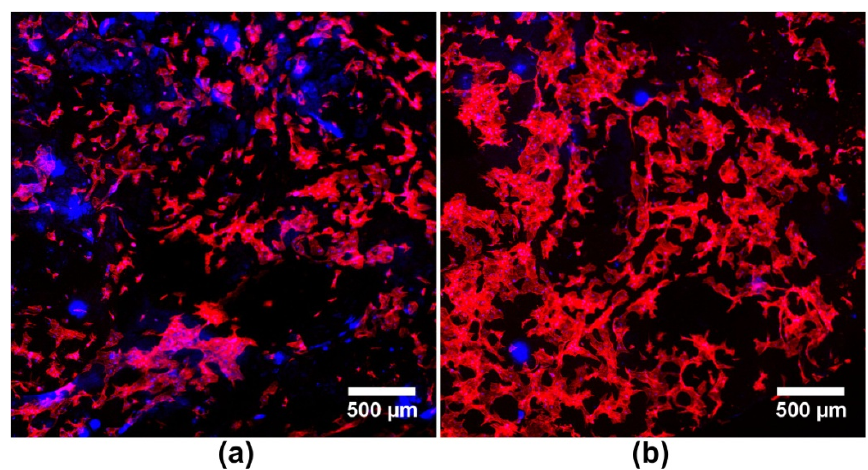
Figure 2. Confocal laser scanning microscope images of MC3T3-E1 preosteoblasts cultured on the surface of biomaterial without and with ferromagnetic nanoparticles (NPs): ( a ) shows MC3T3-E1 cells on chitosan-based scaffold without ferromagnetic NPs; ( b ) shows greater number of better spread MC3T3-E1 preosteoblasts on chitosan-based scaffold with ferromagnetic NPs incorporated within polysaccharide matrix (cell cytoskeleton was stained with AlexaFluor635phalloidin).